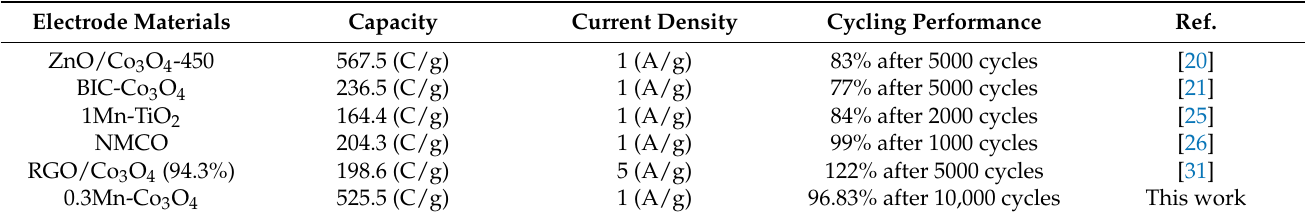
Table 1. Electrochemical performances of several electrode